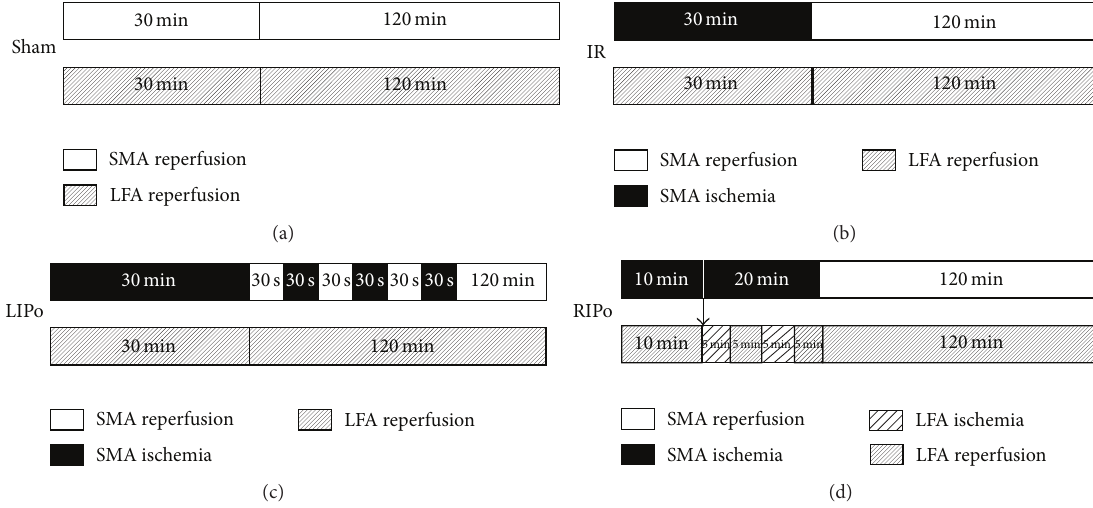
Figure 1: Experimental protocol. (a) Sham: laparotomy exposing the SMA and LFA; (b) I/R: 30 min of SMA occlusion followed by 120min reperfusion with the LFA intact; (c) LIPo: 3 cycles of 30 s reperfusion-reocclusion of SMA were applied at the onset of SMA reperfusion; (d) RIPo: 2 cycles of 5 min reperfusion-reocclusion of the LFA were applied when SMA was occluded for 10min and at the time of SMA